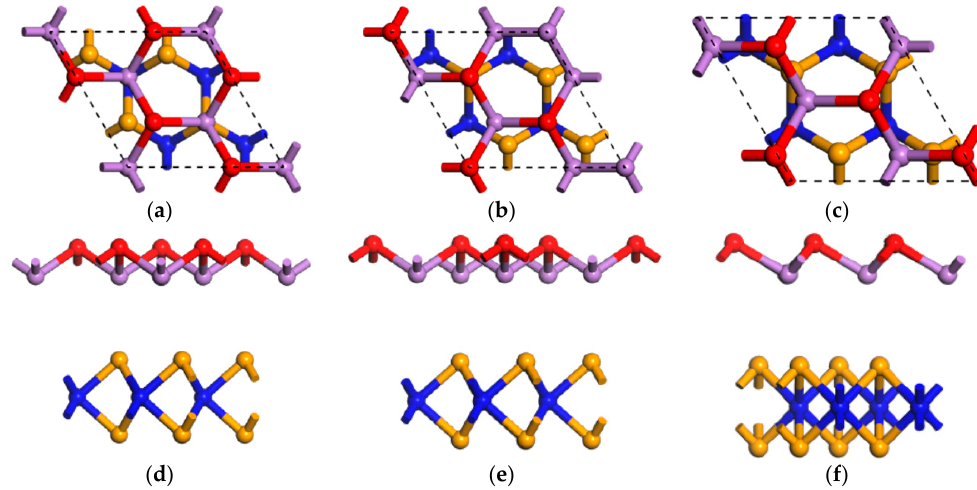
Figure 1. Top and side view of the arsenene/WS 2 heterostructure: ( a , b ) bottom configuration; ( c , d ) top configuration; ( e , f ) center configuration. The red, purple, orange and blue balls represent the up As , bottom As , S, and W atoms, respectively. Table 1. The interlayer distance, D, and binding energy, E b, of the arsenene/WS 2 heterostructure for three stacking configurations.